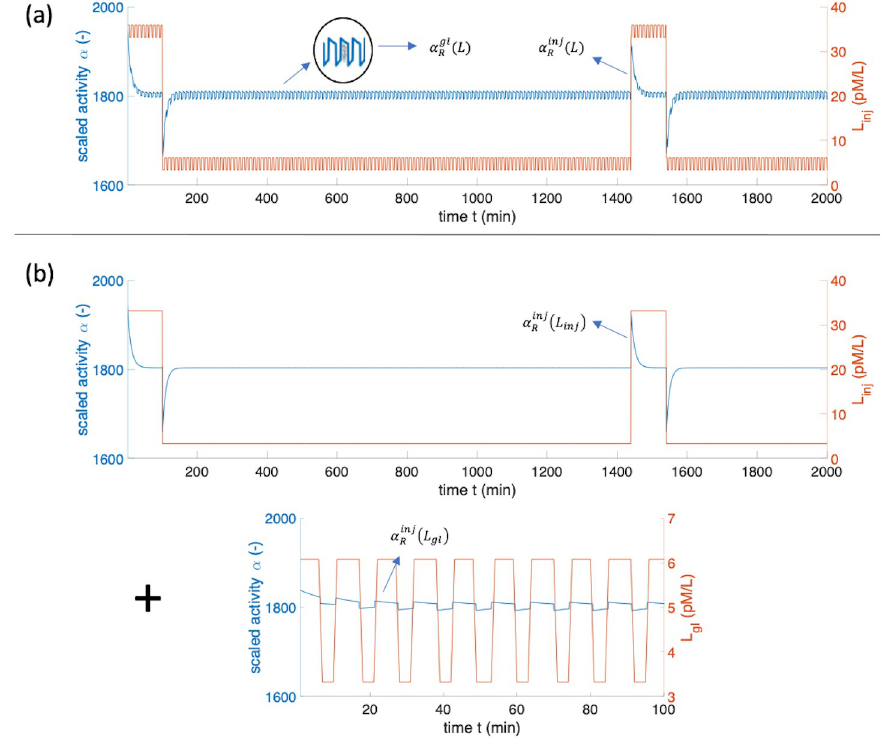
Fig 4. Computational simulation results of two models used to compute scaled activity α and cellular responsiveness α R for the case of combined PTH glandular secretion and external sc daily PTH injection ( D = 20 μ g). (a) refers to model 1 whereas (b) refers to model 2.